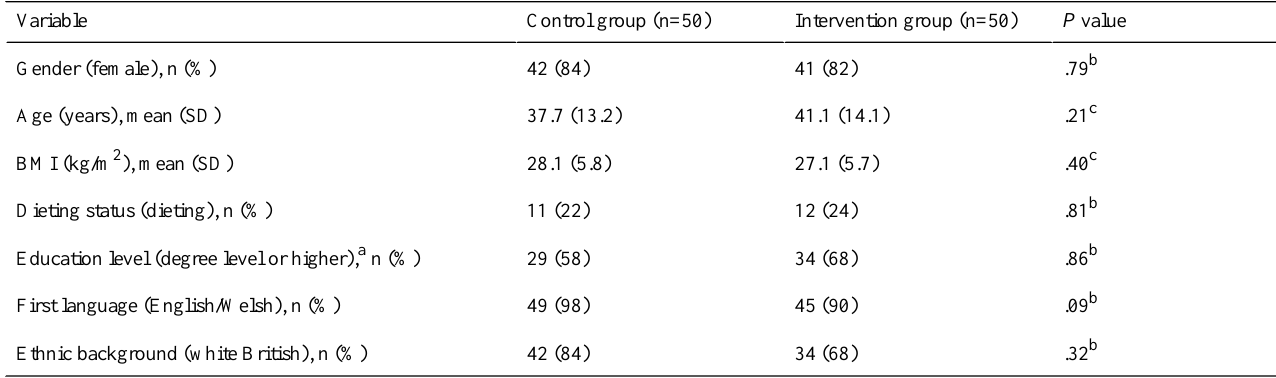
Table 1. Baseline characteristics of the intervention and control groups (N=100).